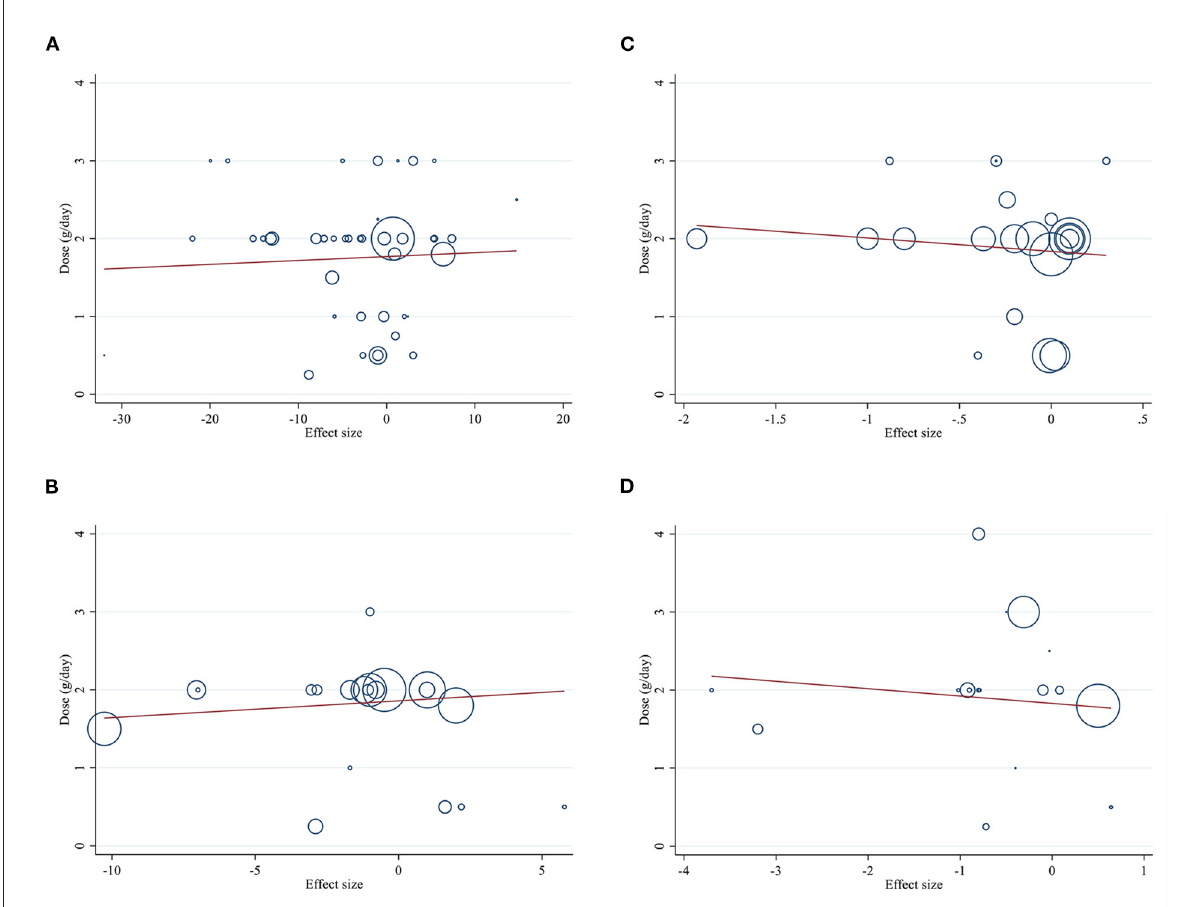
FIGURE6 Linear relations between L-carnitine consumption and absolute mean differences. Dose-response relations between dose (mg/day) and absolute mean differences in (A) FBG (mg/dl); (B) Insulin (pmol/l); (C) HbA1c (%); (D) HOMA-IR. FBG, fasting blood glucose; HOMA-IR, homeostasis model assessment for insulin resistance; HbA1C, hemoglobin